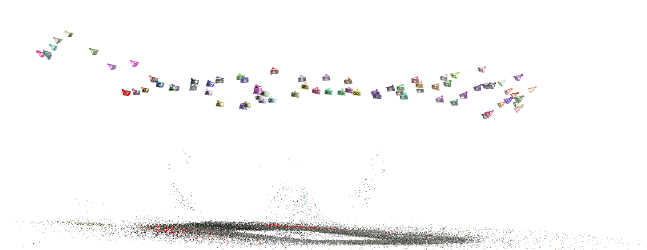
Figure 5. The sparse model in Visual SFM.